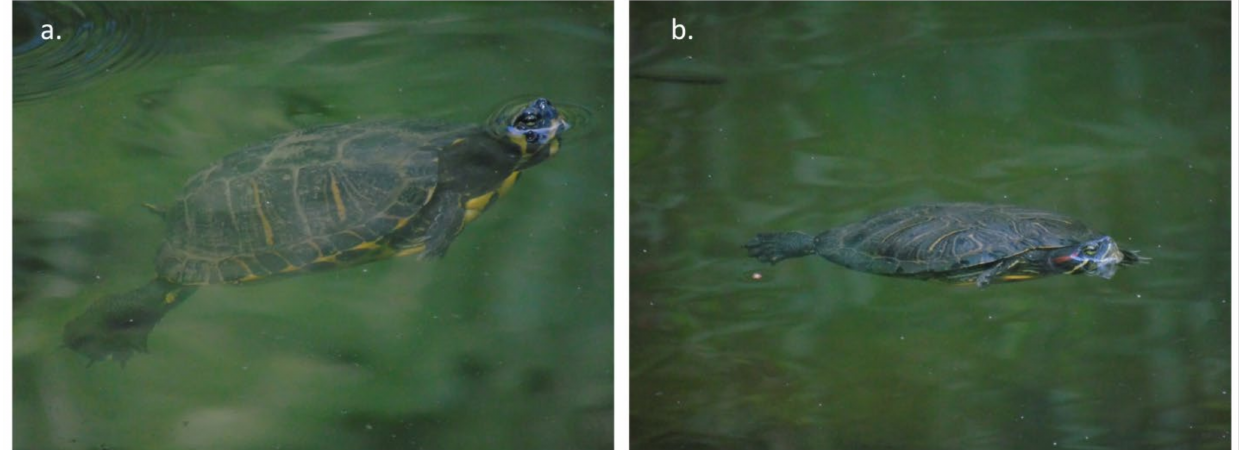
Figure 3. Photographic evidence of the presence of the introduced common slider and its two subspecies on the island of Lesvos, Greece: the coexistence of T. s. scripta ( a ) with T. s. elegans ( b ) in the Vouvaris river